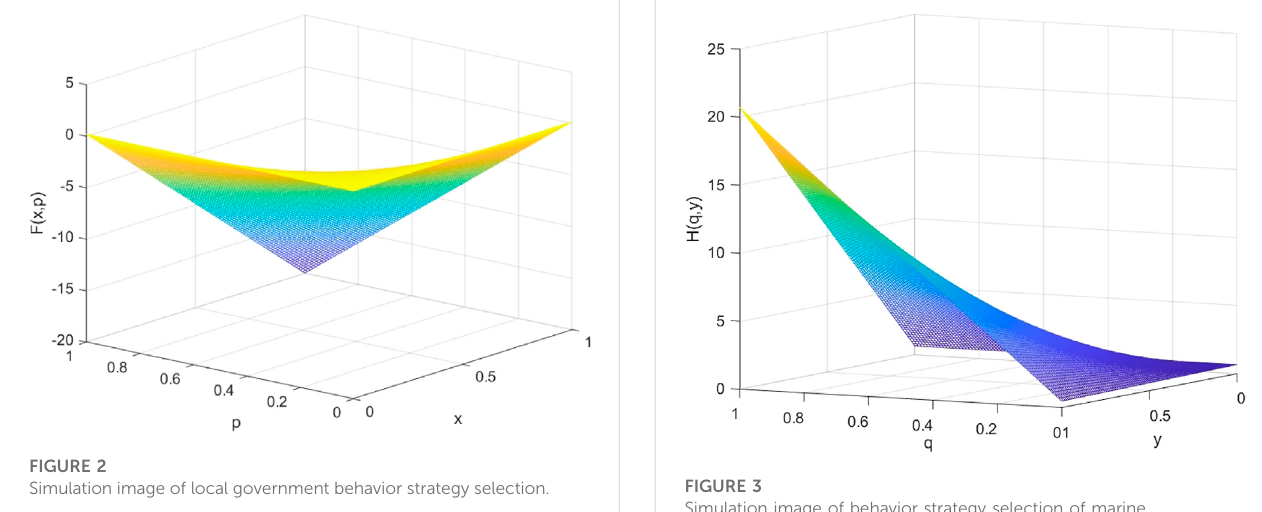
Simulation image of behavior strategy selection of marine production